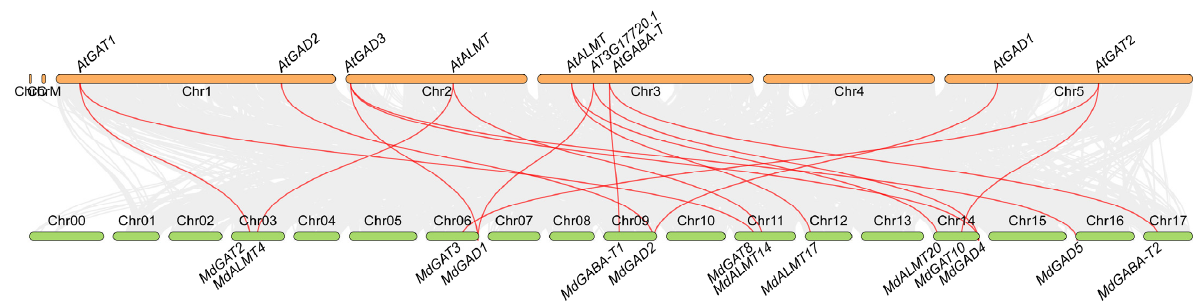
Fig. 3. The comparative synteny map of GABA shunt genes between apple and Arabidopsis genomes.